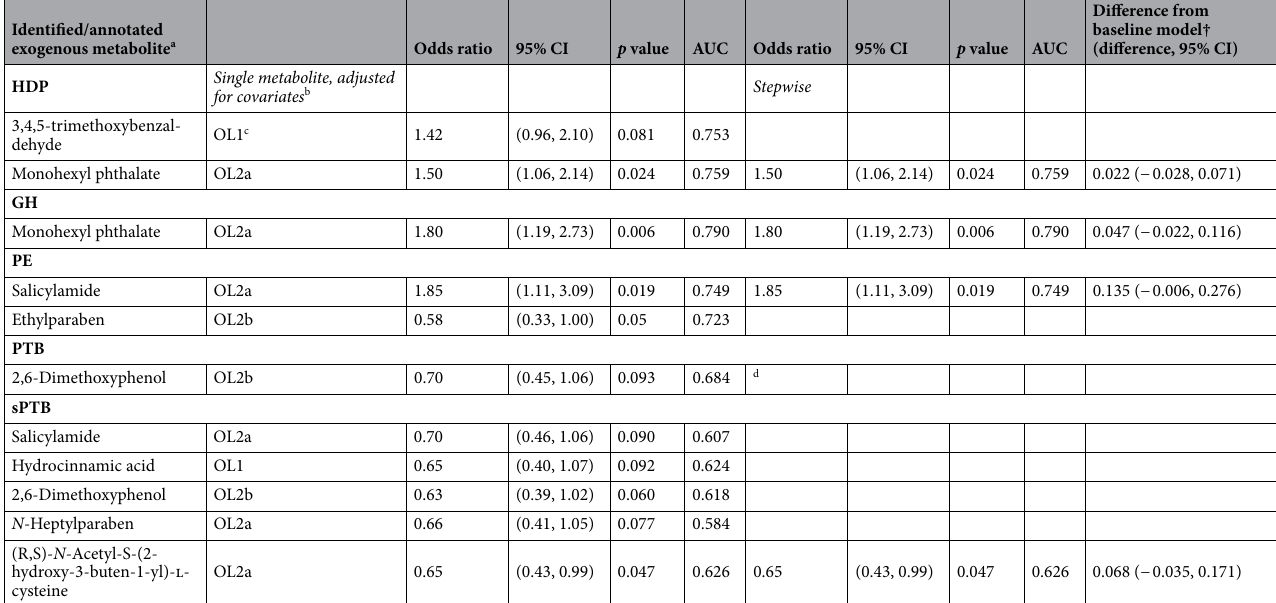
Table 4. Association between exposure of exogenous chemicals and pregnancy complications by stepwise modeling. HDP, any hypertensive disorder of pregnancy; GH, gestational hypertension; PE, pre-eclampsia, PTB, preterm birth; sPTB, spontaneous preterm birth; GDM, gestational diabetes mellitus. a The exogenous metabolites include the exposed parent chemicals and their metabolites or conjugates that are formed in vivo after the exposures. The exogenous metabolite was identified or annotated via matching to an In-house Experimental Standards Library that contains over 300 exogenous metabolite standards, which were prioritized for data acquisition based on previous findings in human exposure studies. b p < 0.10 after adjustment for covariates. Single metabolite models include only one metabolite as well as covariates; stepwise models include all predictive metabolites simultaneously and retain those p < 0.05. Adjustment factors: HDP: BMI at first prenatal care visit, illegal drug use in the year before pregnancy, gravidity; GH: BMI at first prenatal care visit, illegal drug use in the year before pregnancy, gravidity; PE: illegal drug use in the year before pregnancy, gravidity; PTB: obesity, and illegal drug use in the year before pregnancy, gravidity; sPTB: gravidity. c